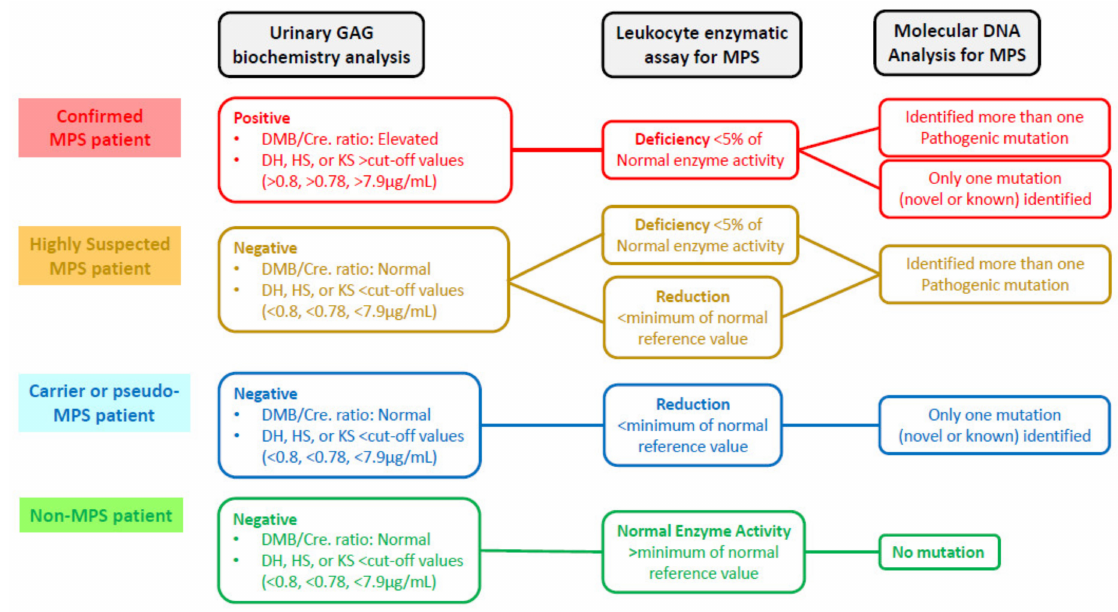
Figure 1. Four diagnostic groups were distinguished—the MPS confirmed group, MPS highly suspected group, MPS carrier or pseudo-MPS group, and non-MPS group—based on the results analyzed from urinary biochemistry tests, leukocyte enzyme activity assay, and molecular gene